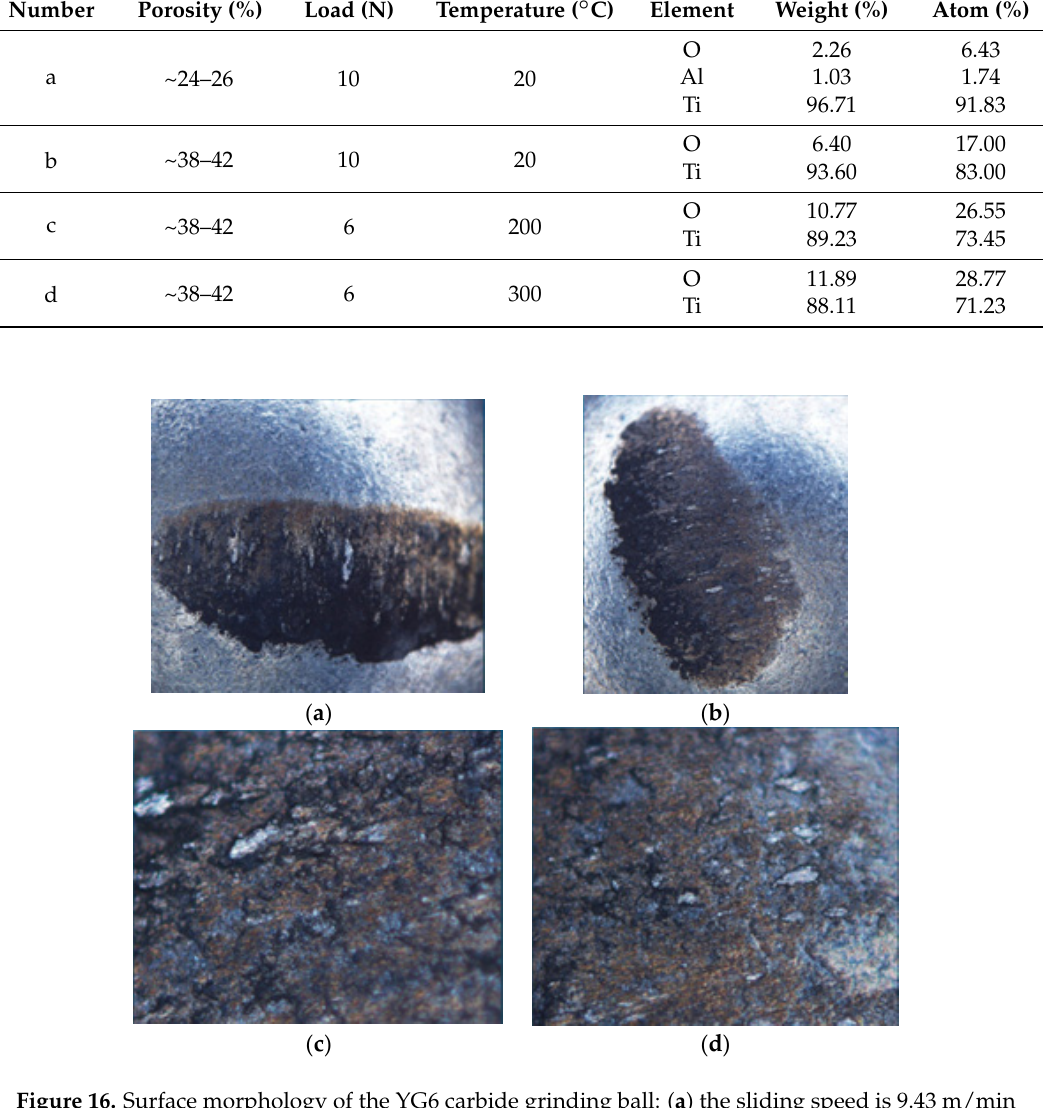
Figure 16. Surface morphology of the YG6 carbide grinding ball: ( a ) the sliding speed is 9.43 m/min and the magnification is 139×; ( b ) the sliding speed is 12.56 m/min and the magnification is 139×; ( c ) the sliding speed is 12.56 m/min and the magnification is 800×; and ( d ) the sliding speed is 12.56 m/min and the magnification is 600×.